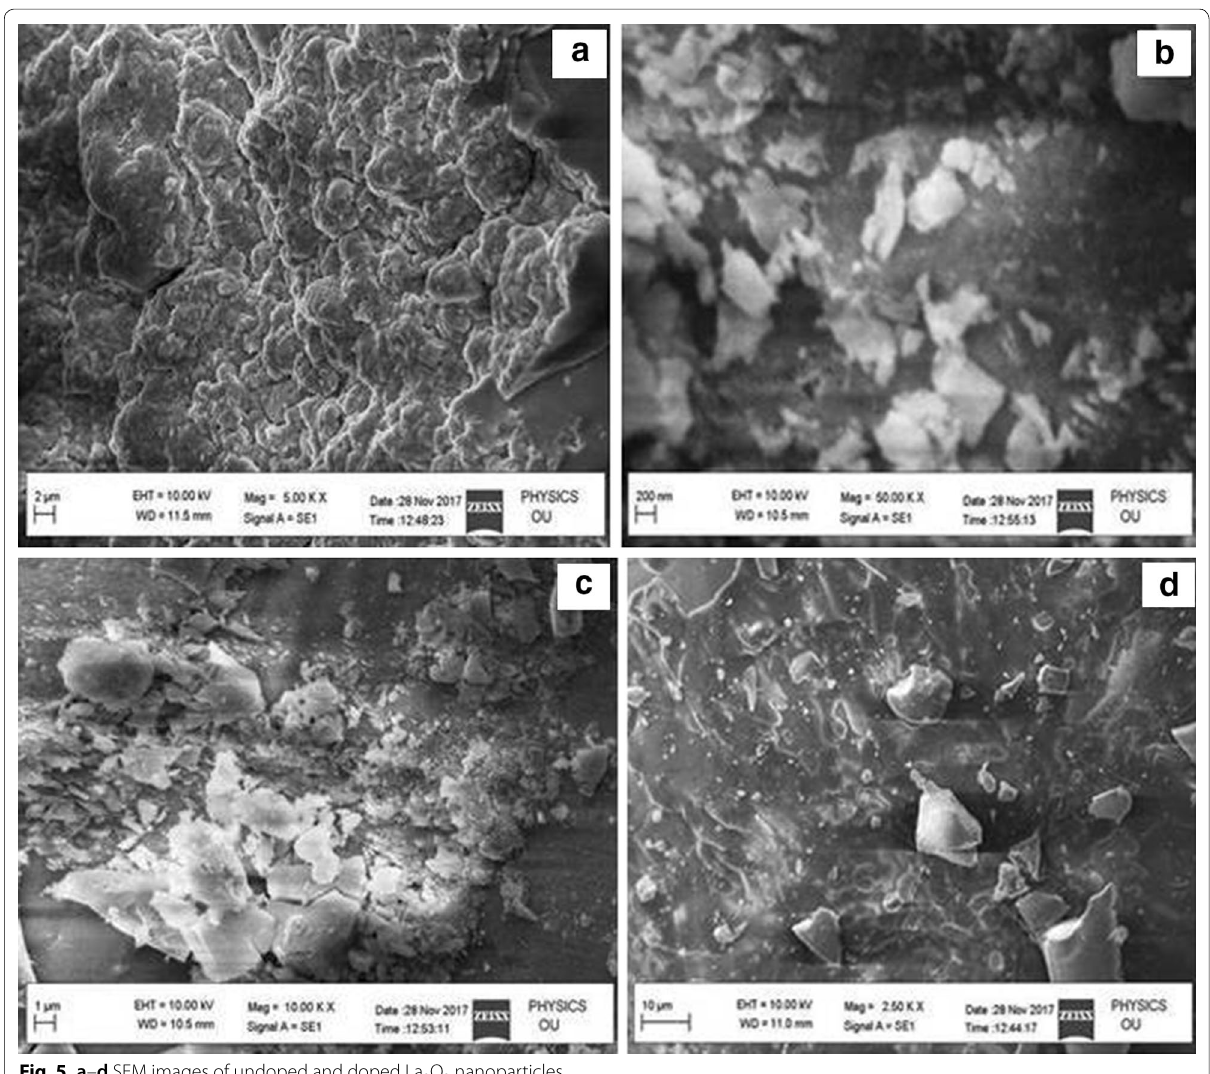
Fig. 5 a – d SEM images of undoped and doped La 2 O 3